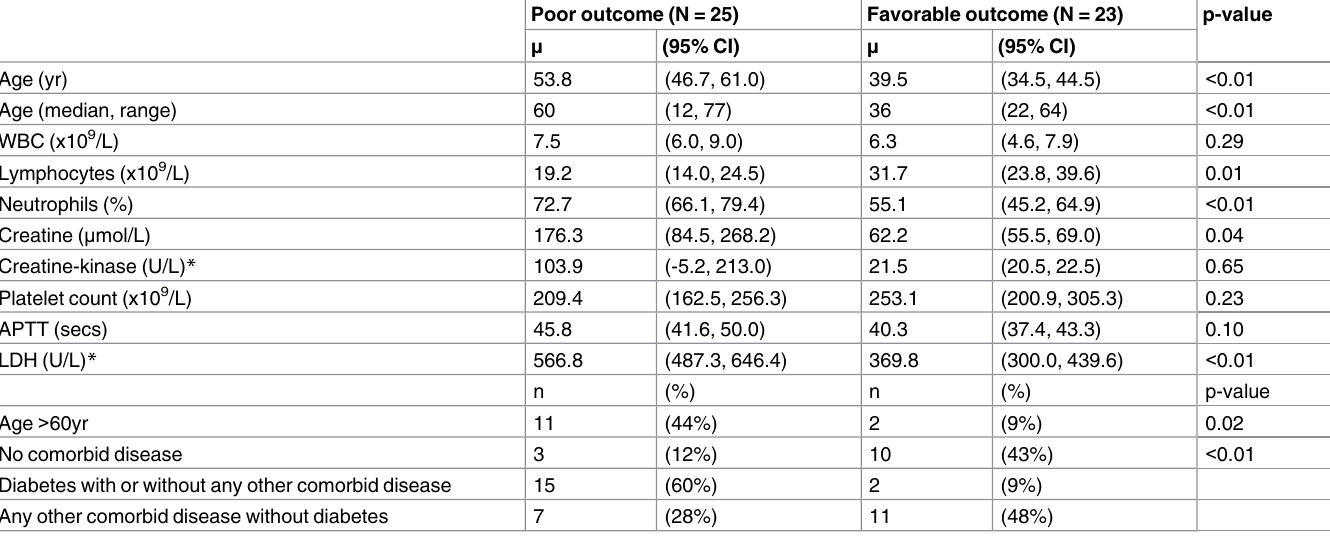
Table 6. Factors associated with poor outcome (admission to ICU or death) among 48 MERS patients.